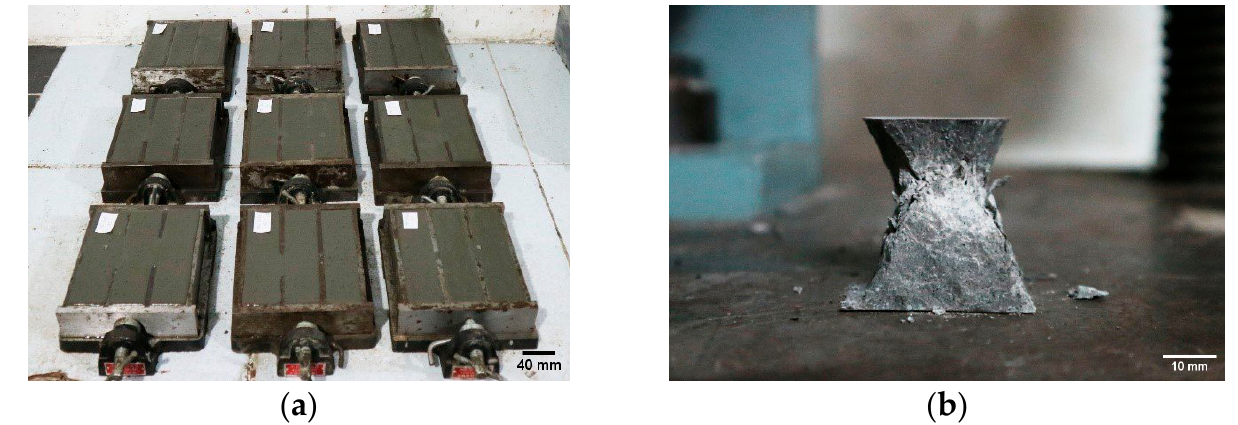
Figure 5. Testing sample for cement paste. ( a ) Specimens of cement paste, ( b ) The shape of a sample after testing.